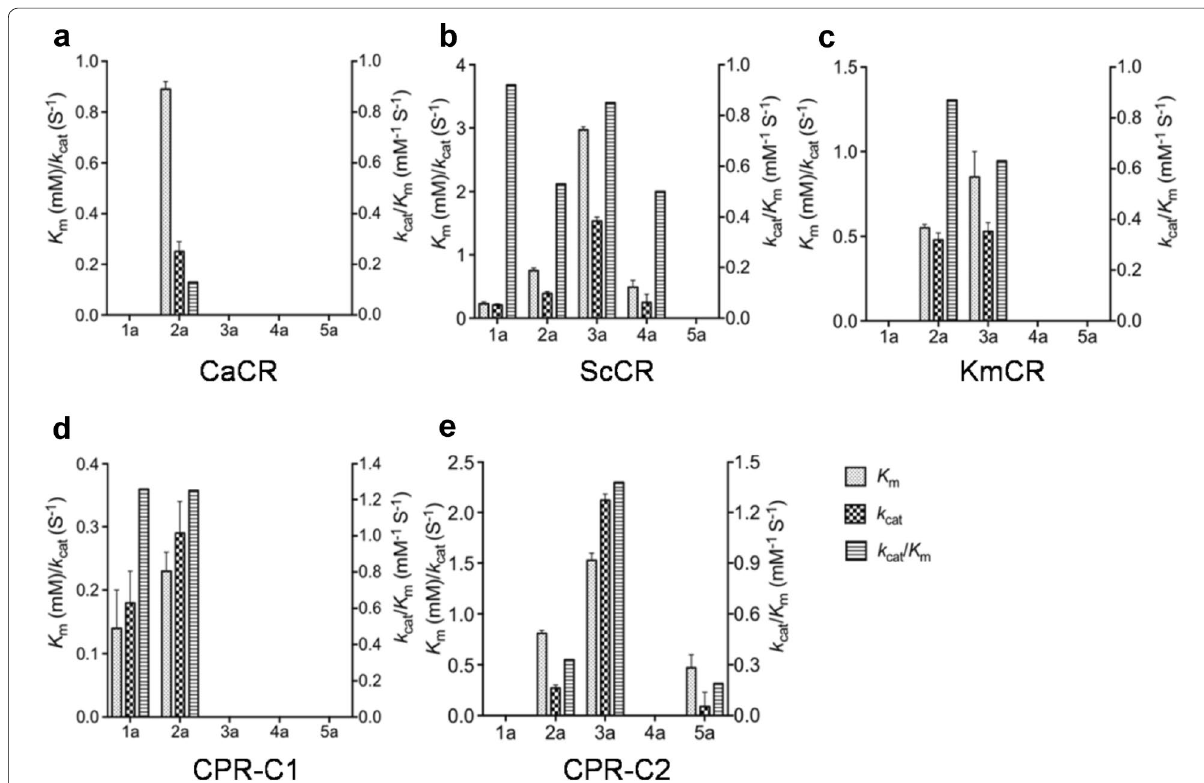
Fig. 4 Apparent kinetic parameters of the enzymes, including a CaCR, b ScCR, c KmCR, d CPR-C1, and e CPR-C2 in reduction of the carbonyl substrates. The primary Y-axis “ K